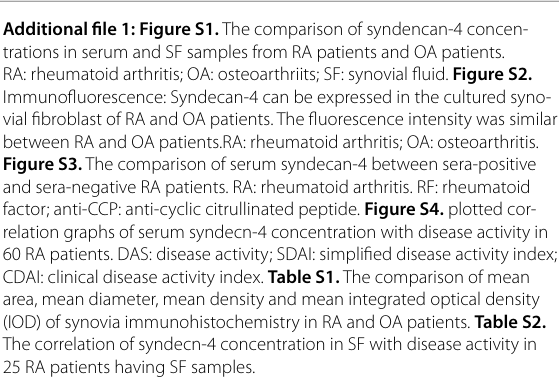
factor; anti-CCP: anti-cyclic citrullinated peptide. Figure S4. plotted cor- relation graphs of serum syndecn-4 concentration with disease activity in 60 RA patients. DAS: disease activity; SDAI: simplified disease activity index; CDAI: clinical disease activity index. Table S1. The comparison of